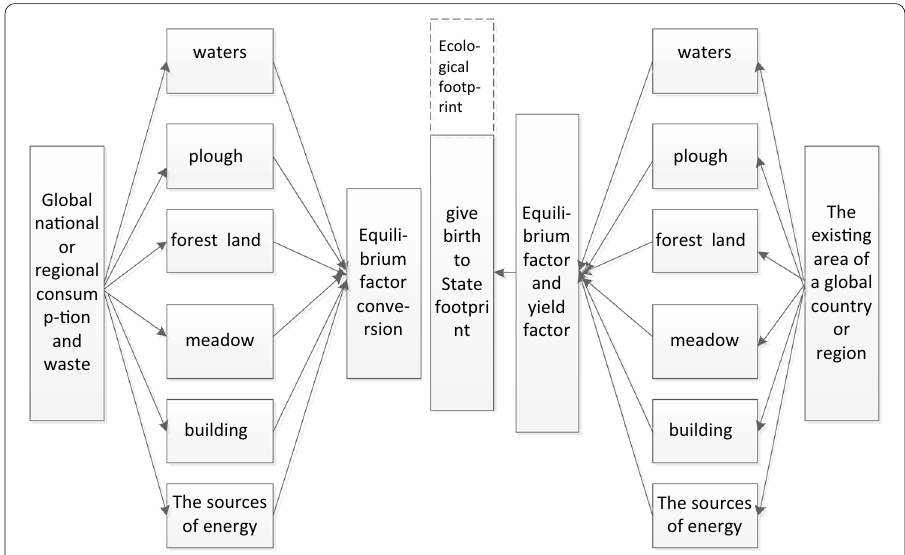
Fig. 1 Schematic diagram of calculation process of ecological footprint